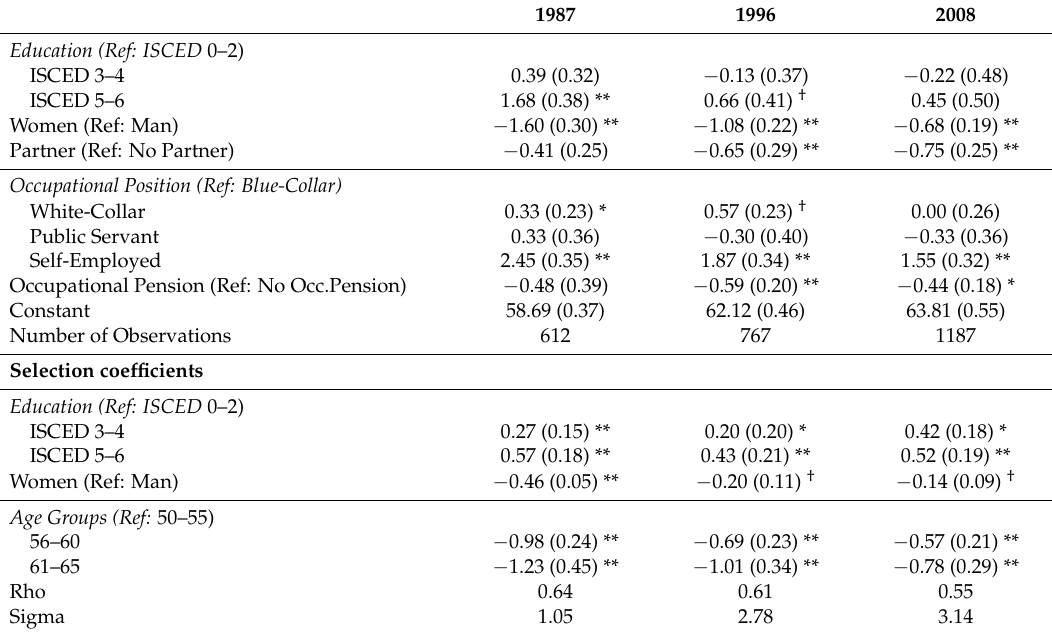
Table A1. OLS Regression on the Expected Retirement Age with Heckman Test